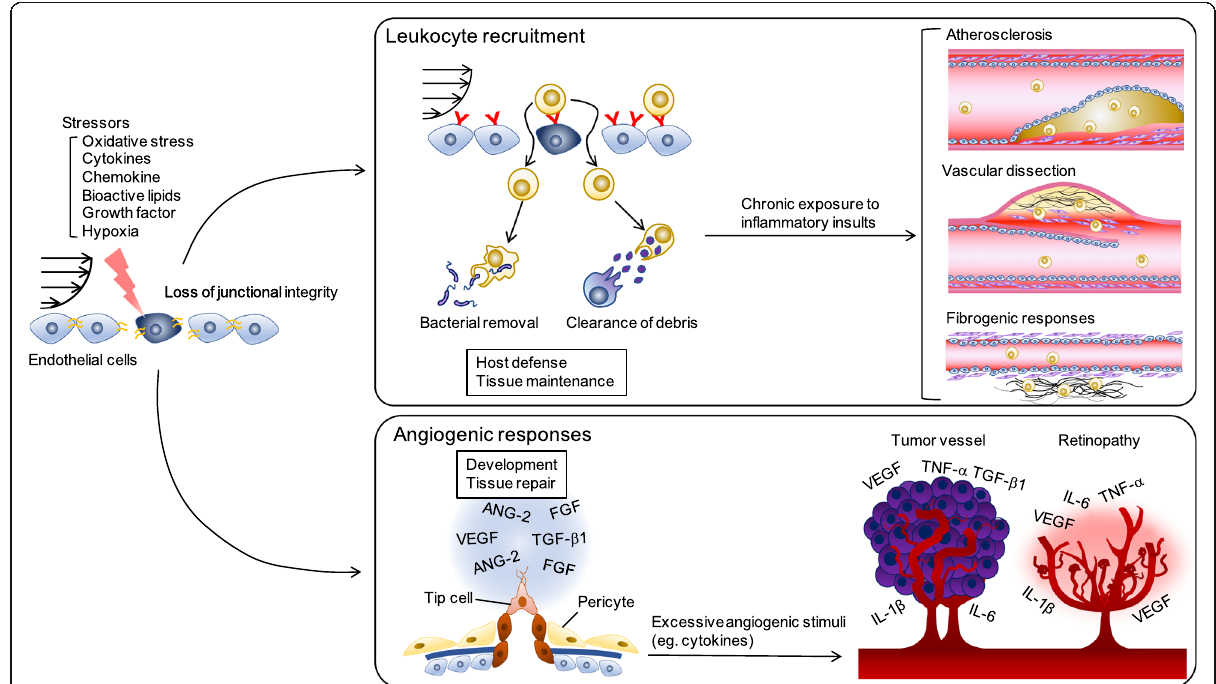
Fig. 1 Endothelial adaptation to the inflammatory environment and related vascular disorders. Variety of stressors can elicit shedding of intercellular junctions in ECs (left). Loss of junctional integrity leads to recruitment of the leukocytes into the subendothelial spaces. While this adaptive event is required for the host defense and tissue maintenance, prolonged and excessive inflammatory responses cause failure of adaptation, thereby inducing fibrogenic responses in adjacent microenvironment as well as atherosclerosis and vascular dissection in large blood vessels (upper right). When ECs are subjected to the angiogenic stimuli, they migrate toward the interstitinal spaces to form new blood vessel network. Such angiogenic responses are indispensable for the tissue development and repair. However, excessive and redundant angiogenic stimuli, such as combination of growth factors and inflammatory cytokines, lead to aberrant angiogenic regulations, leading to the pathological angiogenesis, such as tumor angiogenesis and retinopathy (lower right). ANG-2: angiopoietin-2; EC: endothelial cell; FGF: fibroblast growth factor; IL-1 β : interleukin-1 β ; IL-6: interleukin-6; TGF- β 1: transforming growth factor- β 1; TNF- α : tumor necrosis factor- α ; VEGF: vascular endothelial growth